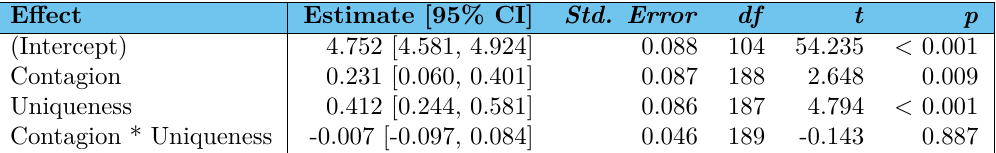
Table 2. Parameter Estimates for the Linear Mixed Model in Study